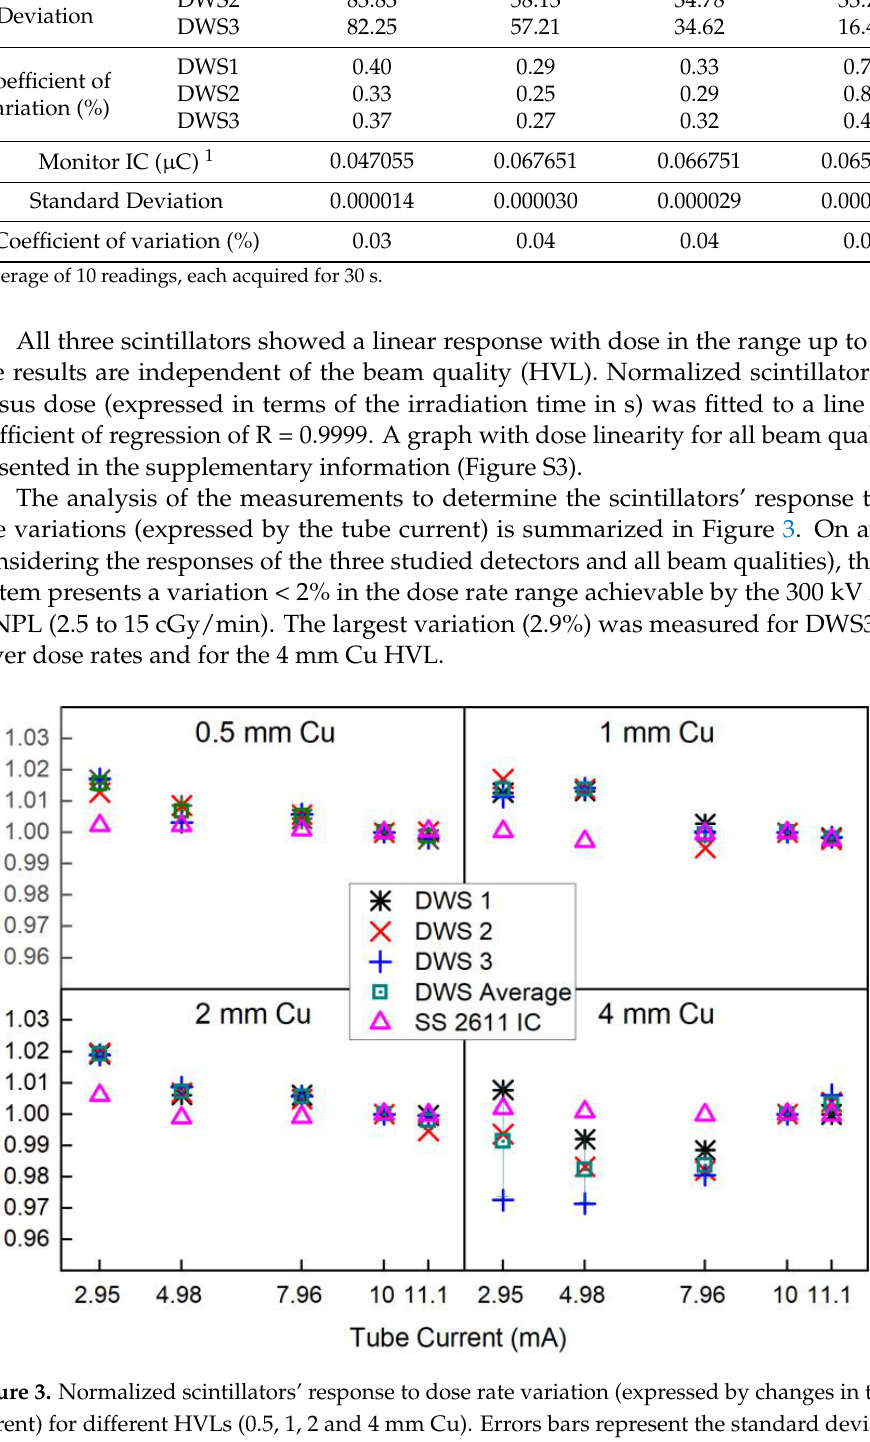
( b ) Figure 4. Angular response of DWS 1 scintillator detector. ( a ) longitudinal response, ( b ) polar re- sponse. Response is normalized against the signal measured at SARRP 0° gantry angle. SD corre- spond to the standard deviation of three readings at each gantry angle.